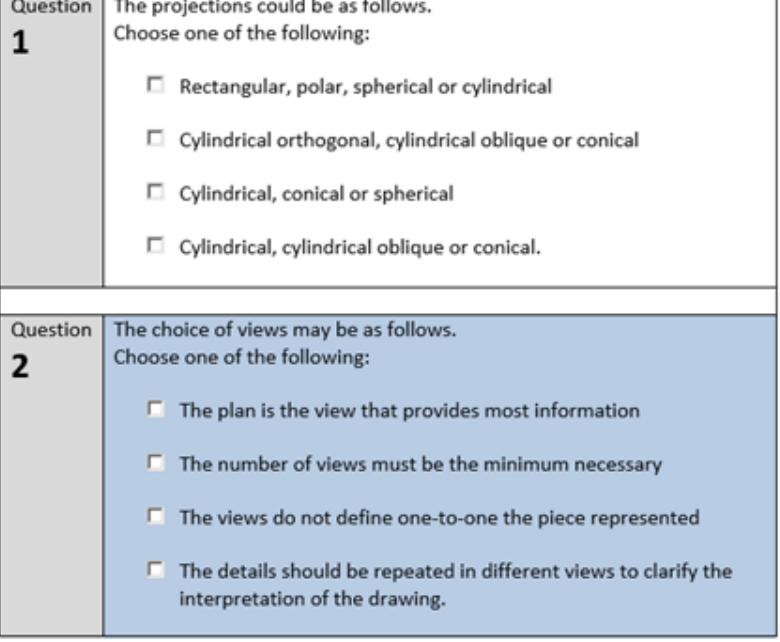
Figure 2. Assessment